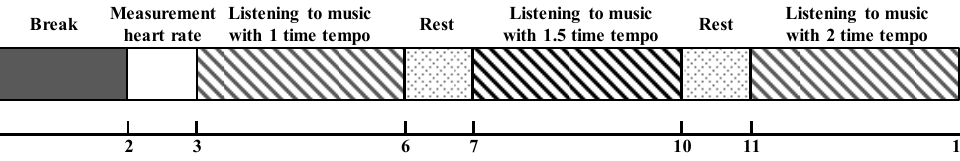
Figure 10. Experimental flow about relationship between heart rate and tempo of music.